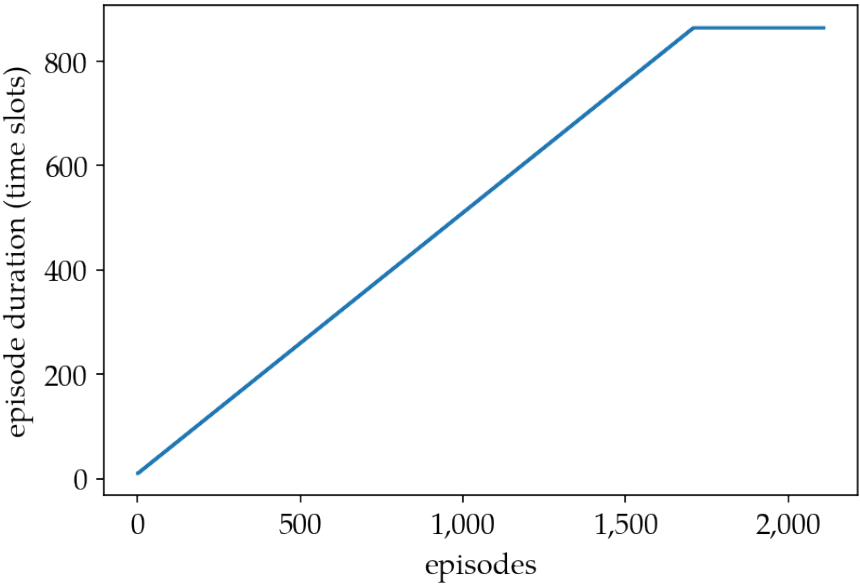
Figure 15. Plot of incremental episode duration during training (three-day episode duration).